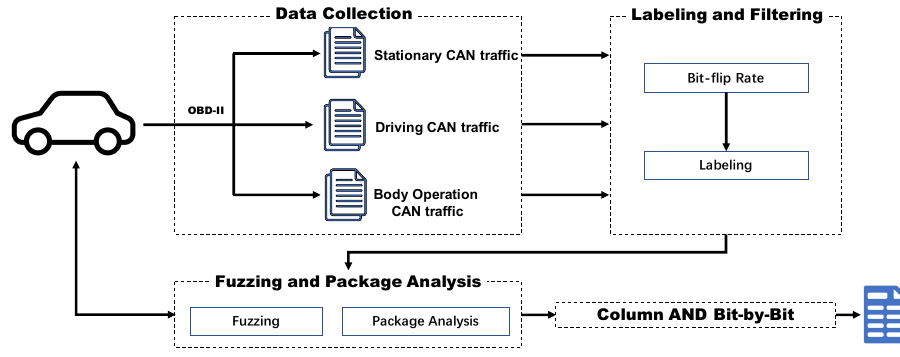
Figure 2. Overall flow of the translating method.